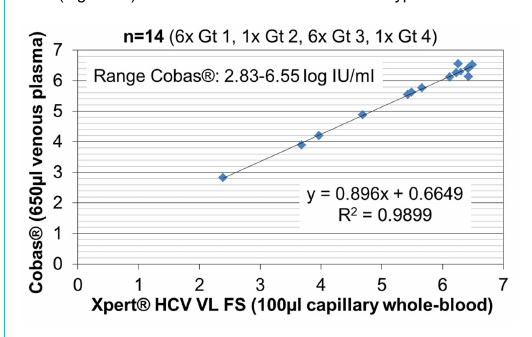
Figure 4: Quantitative performance of the Xpert ® HCV Viral Load Finger-Stick (VL FS) test: correlation of quantifiable HCV RNA re- sults (log IU/ml) with the reference test.Gt =